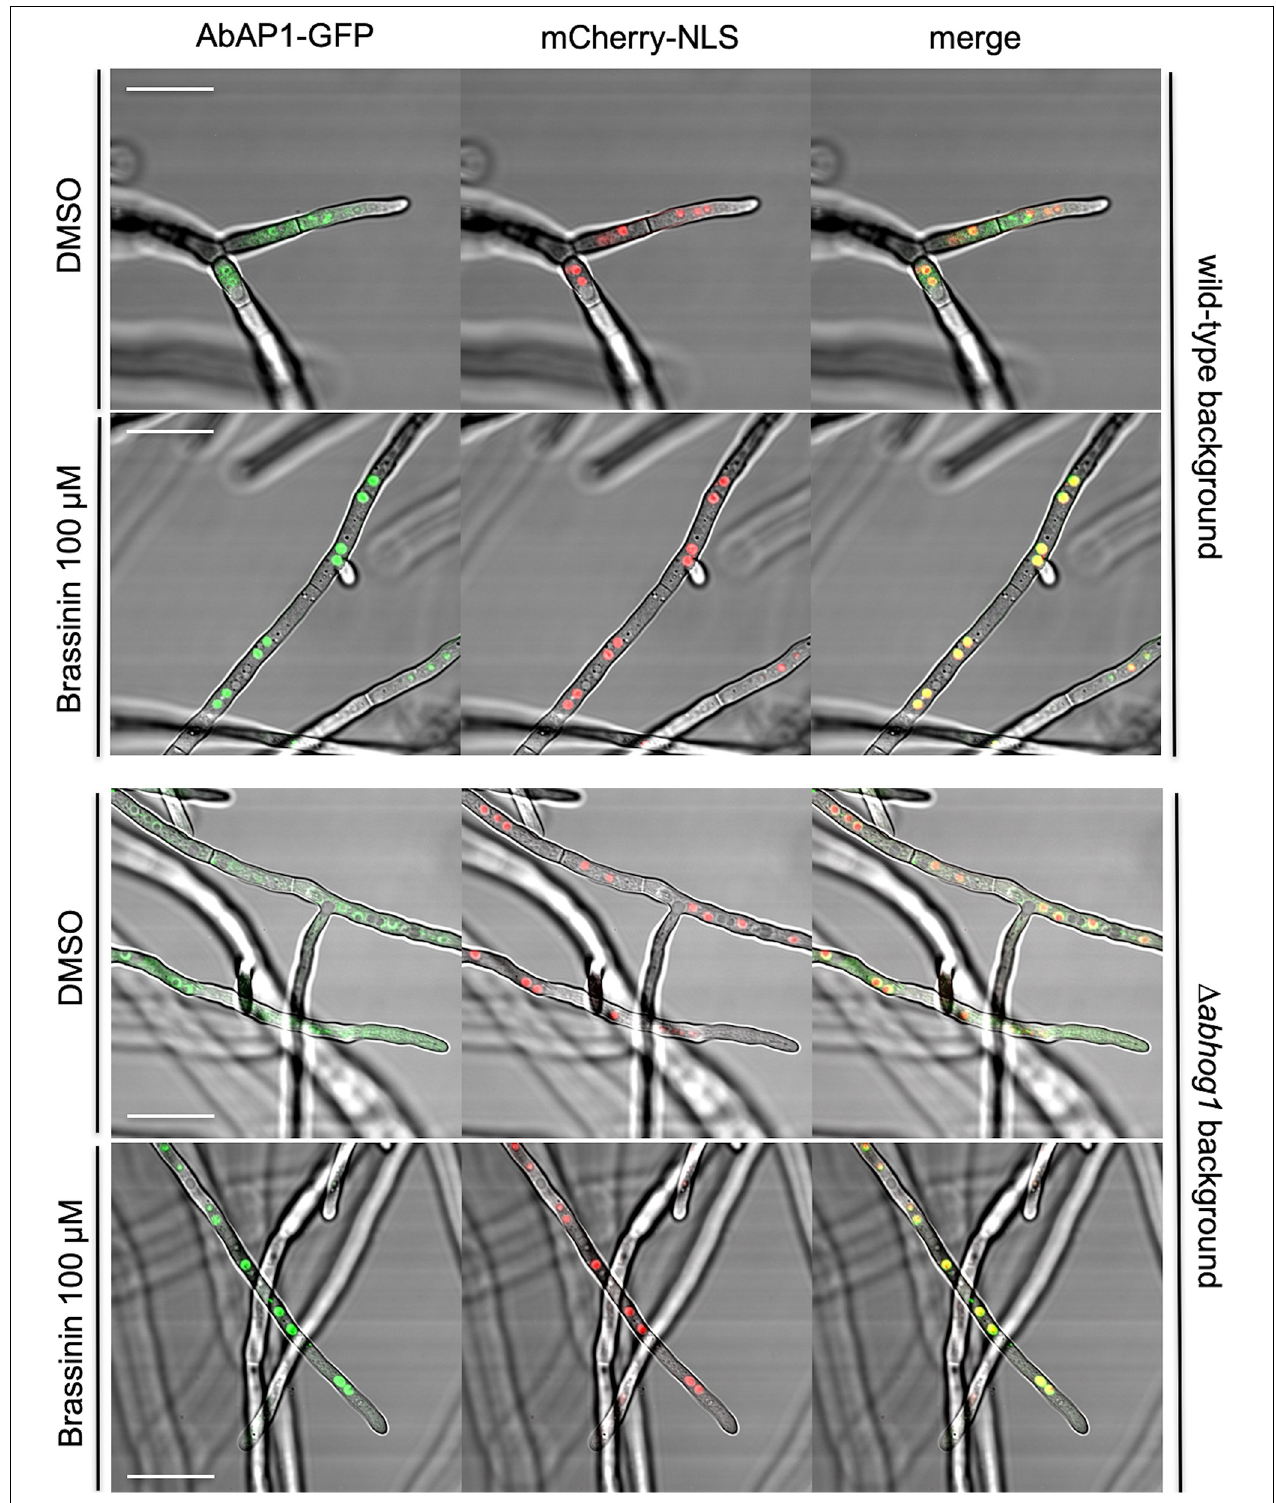
FIGURE 8 | Cellular localization of the AbAP1-GFP fusion protein in the wild-type background and (cid:49) abhog1 background. Double-labeled strains expressing mCherry-NLS and AbAP1-GFP were exposed to either DMSO (control) or 100 µ M brassininin for 0.5 h. Bars = 25 µ m.